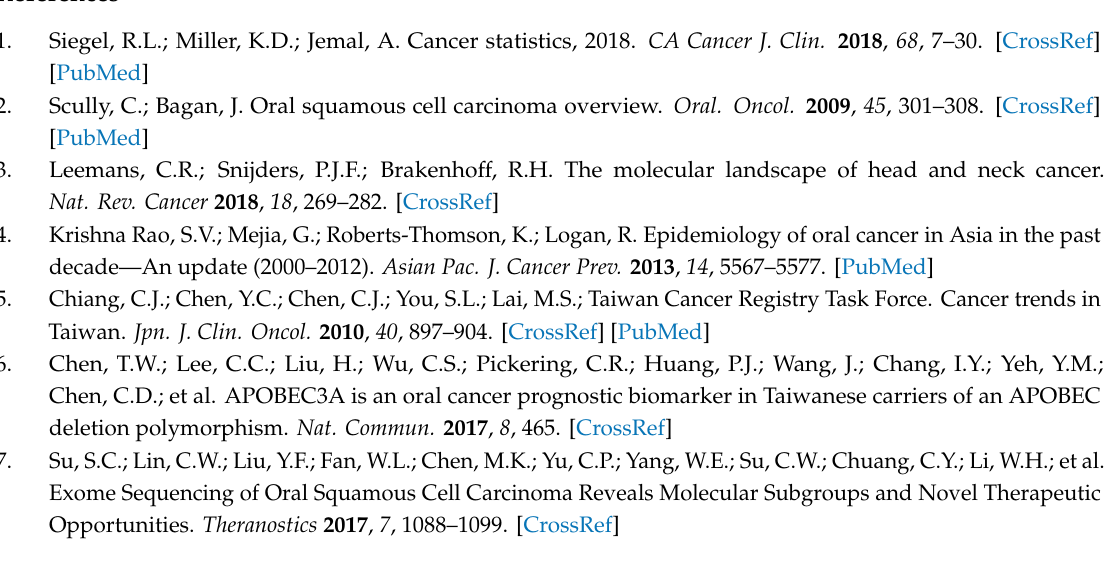
Figure S1: Transcriptome alterations in OSCC tumors; Figure S2: Enriched cancer hallmarks in three OSCC patients; Figure S3: Pathway enrichment analysis of 39 paired OSCC transcriptome datasets; Figure S4. Kaplan-Meier survival curves for overall survival according to the levels of CHEK1, PIK3CA, and PIK3CD in HNSCCs; Figure S5: Screening of CHK1 inhibitors in OSCC cell lines; Figure S6: CHK1 inhibitors e ff ectively inhibit the UV-induced phosphorylation of CHK1; Figure S7: Uncropped scans of Western blots in Figure S6; Figure S8: E ff ects of cisplatin in OSCC cell lines, Figure S9. Uncropped scans of Western blots in Figure 3g; Figure S10: Screening of PI3K inhibitors in OSCC cell lines; Figure S11: PI3K inhibitors e ff ectively inhibit the phosphorylation of AKT; Figure S12: Uncropped scans of Western blots in Figure S11; Figure S13: Uncropped scans of Western blots in Figure 4e; Figure S14: PF477736 and cisplatin treatment in OSCC PDX models; Figure S15: BYL719 and PF477736 treatment in OSCC PDX models; Figure S16: Body weight of OSCC PDX models upon treatment. Table S1: Clinical characteristics of 27 OSCC patients in the first cohort; Table S2: Clinical characteristics related to PIK3CA and PIK3CD expression in the OSCC transcriptome